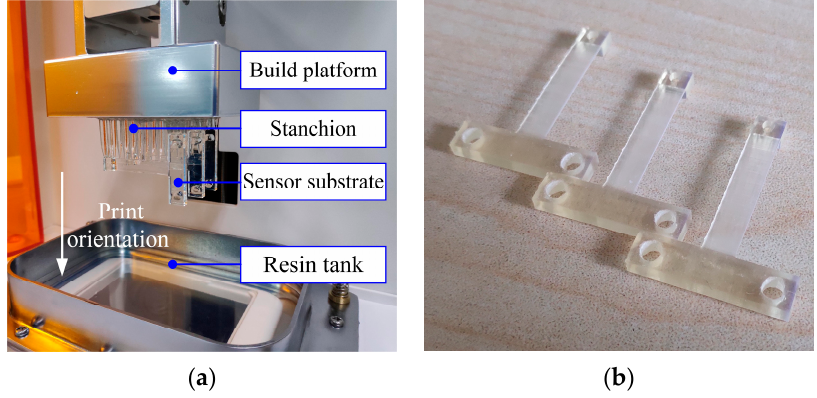
Figure 6. Pictures of the sensor substrates: ( a ) After printing; ( b ) after ultraviolet curing.